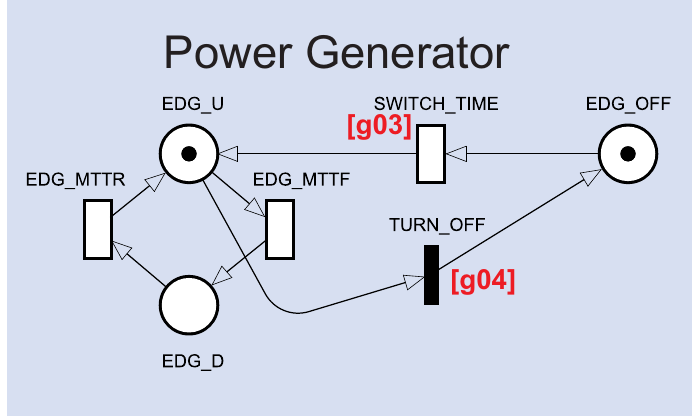
Figure 4. Power Generator component.